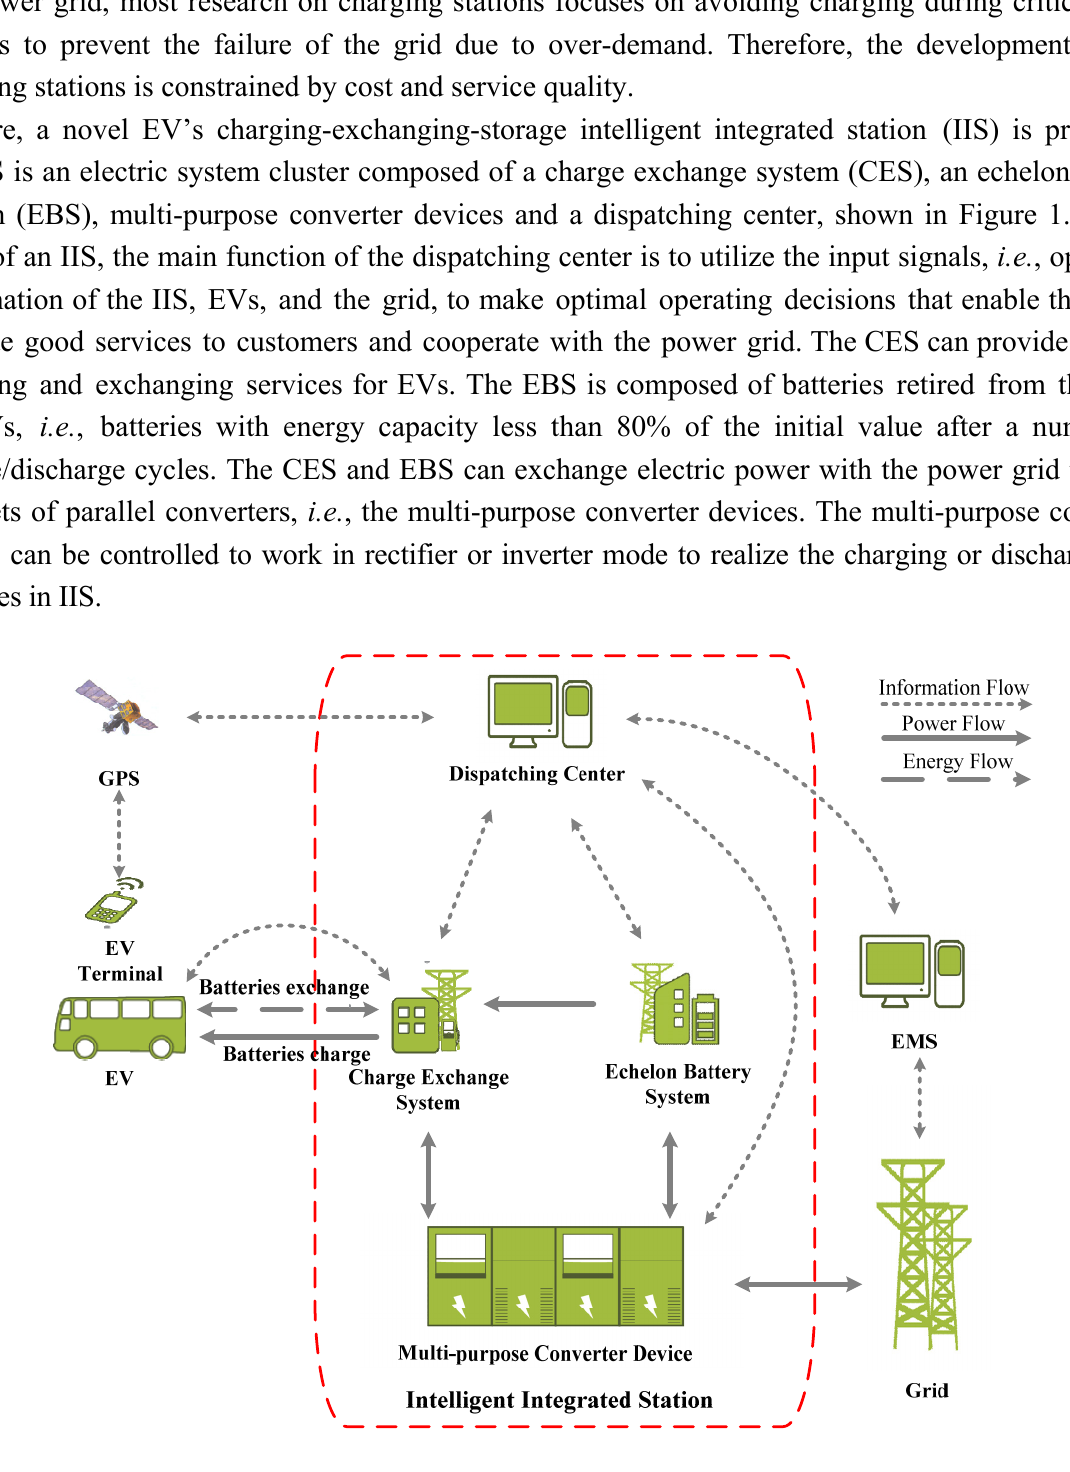
Figure 1. Power flow and information flow in intelligent integrated station